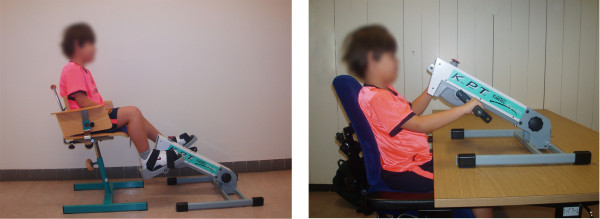
Posture during dynamic leg and arm training